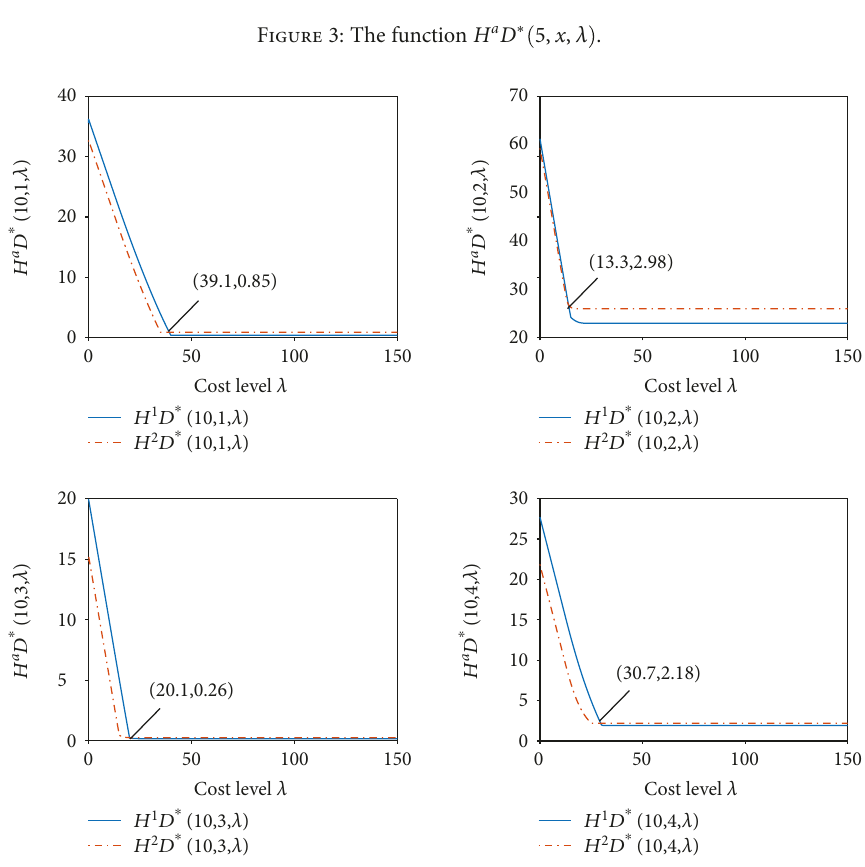
Figure 4: The function H a D ∗ 10, x , λ